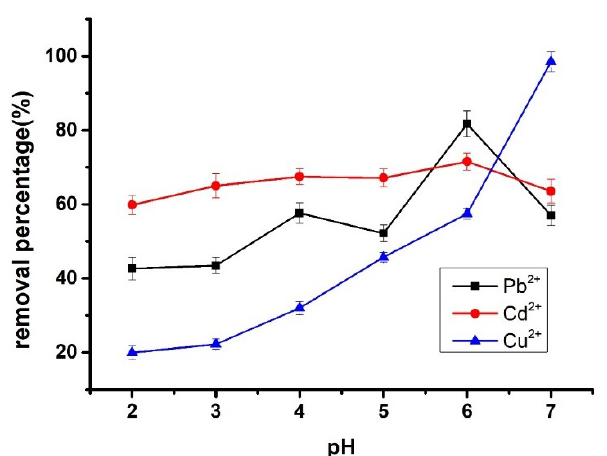
Figure 6. E ff ect of pH value on the adsorption of Pb 2 + , Cd 2 + , and Cu 2 + onto the adsorbents at an ion Figure 6. Effect of pH value on the adsorption of Pb 2+ , Cd 2+ , and Cu 2+ onto the adsorbents at an ion concentration of 125 mg · L − 1 , an adsorbent dose of 12.5 g · L − 1 , an agitation speed of 150 rpm, a solution concentration of 125 mg·L −1 , an adsorbent dose of 12.5 g·L −1 , an agitation speed of 150 rpm, a solution temperature of 30 ◦ C, and a contact time of 24 temperature of 30 °C, and a contact time of 24 h.